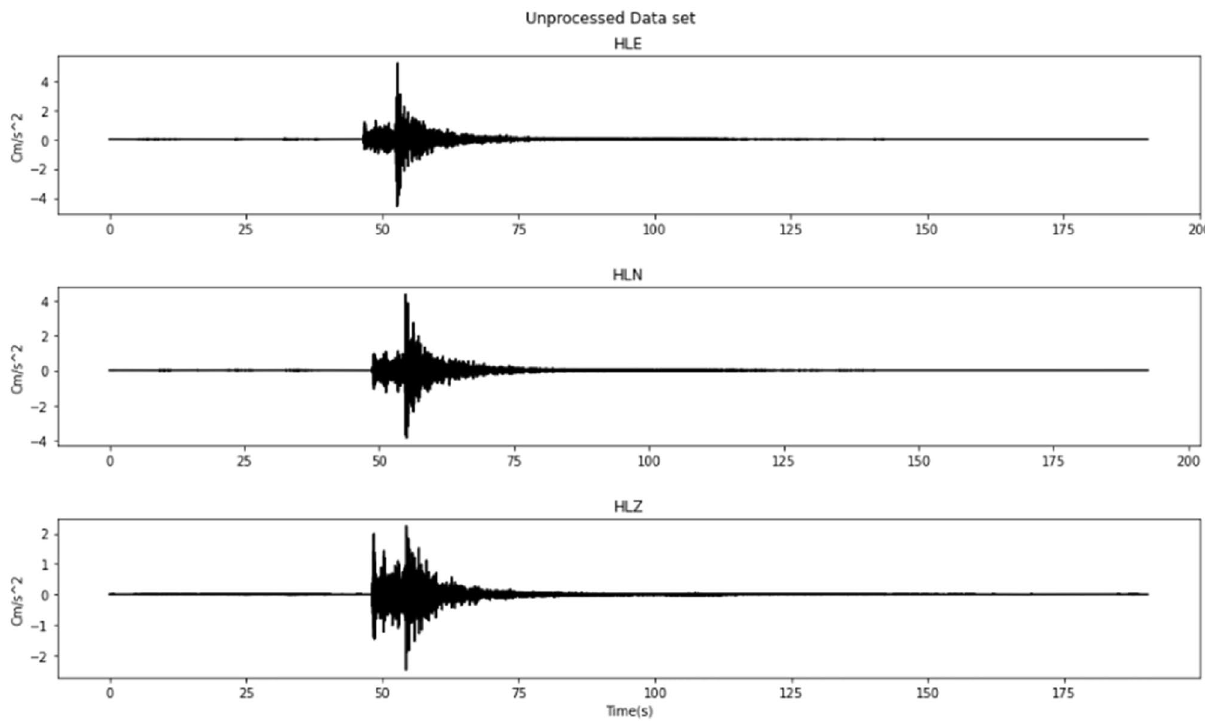
Figure 2. Unprocessed dataset for each channel for 1